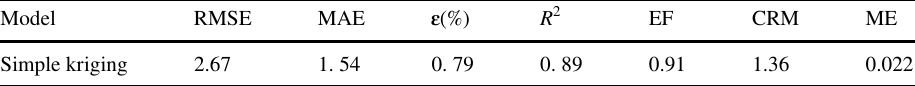
Table 3 Performance indicators (RMSE, MAE, ε , R 2 , EF, CRM, ME) for